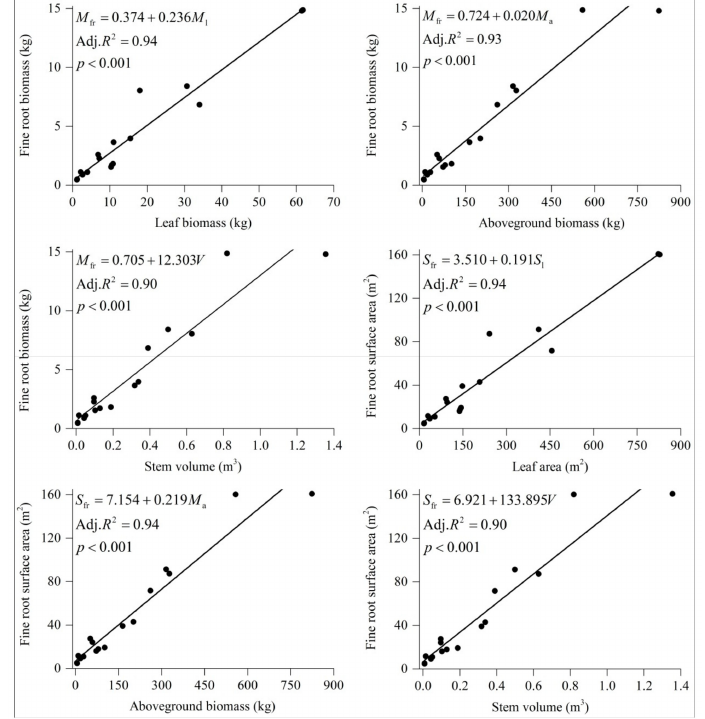
Figure 3. Parameter estimates and their adjusted R 2 values and p values of regression relationships between fine root and aboveground traits at the individual tree